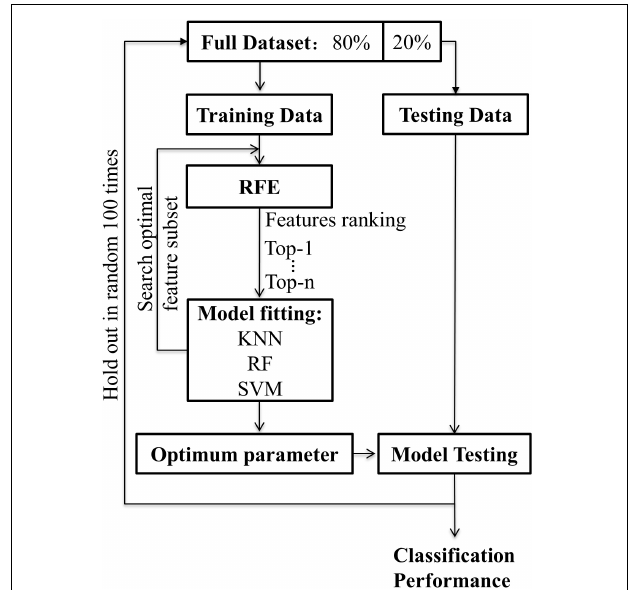
FIGURE 2 | The flowchart for machine learning. Recursive feature elimination was used to search for the optimal feature subset. The classification algorithm was respectively used KNN, RF, SVM (linear, poly, rbf, sigmoid). The hold-out method was repeated 100 times randomly with 80% of the data for training and 20% for